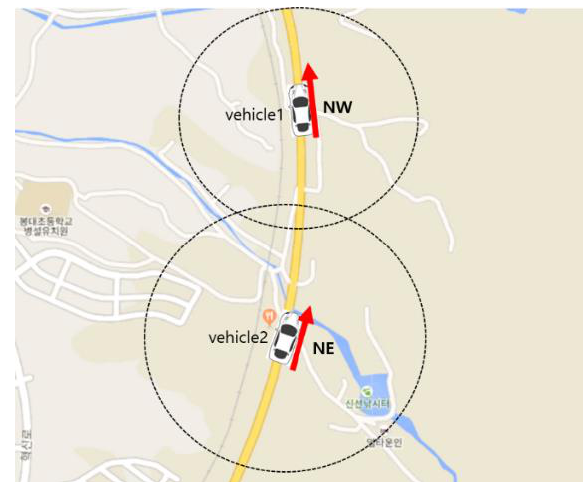
Figure 1. Situation for same driving directions but different headings.